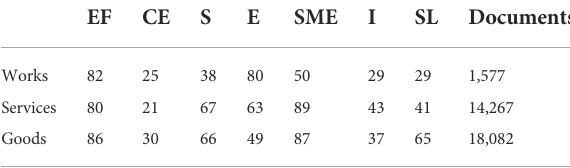
TABLE8SPPmaincategorybyaveragetenderprice×millionCNY( n = 34,977).